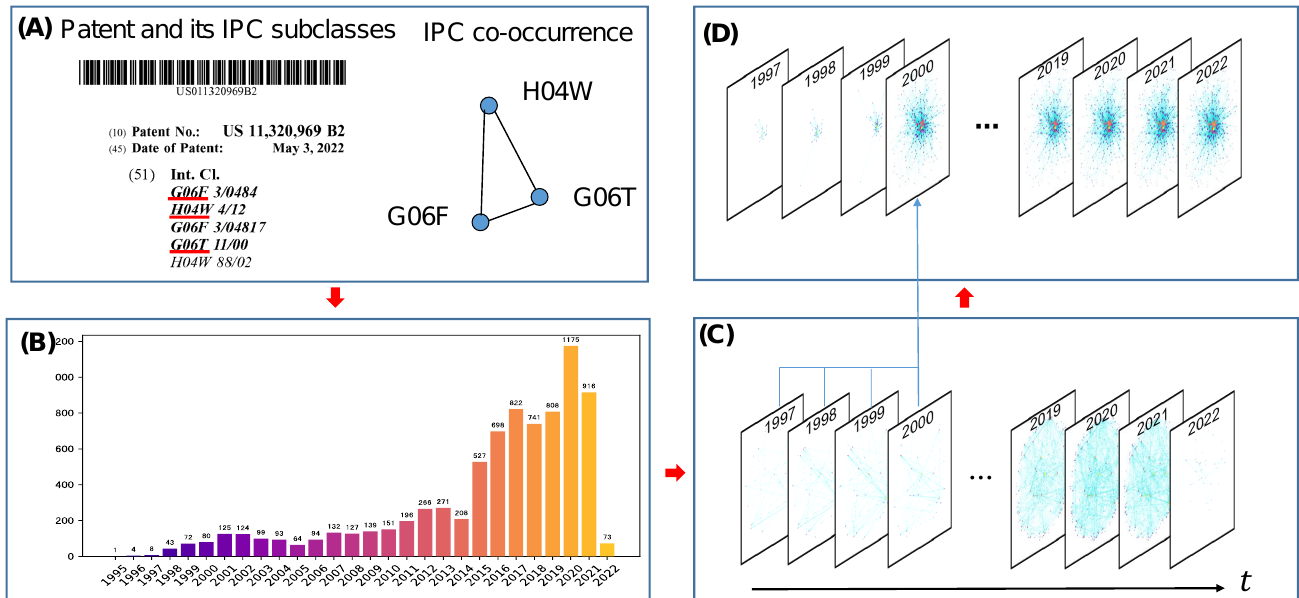
Figure 2. The complete procedure for the technology-convergence network construction. Sub-figure ( A ) shows an example of the patent data, to which three IPC4 codes were assigned. The three IPC4 codes are highlighted by red underlines. The patent in sub-figure ( A ) corresponds to three pairwise co-occurrence relationships. Sub-figure ( B ) shows the number of patent applications in each year. Sub- figures ( C , D ) show the annual and historically cumulative IPC co-occurrence networks,